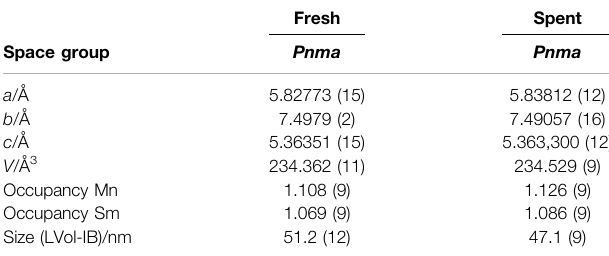
TABLE 1 | Lattice parameters obtained form XRD analysis of fresh and spent Sm 0.96 MnO 3 catalysts.